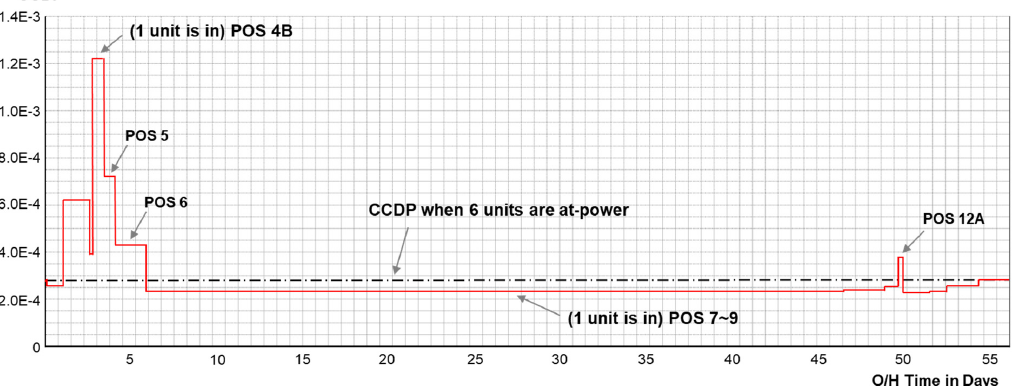
Figure 1. Example of POS-dependent site CCDP profile (one unit in shutdown, five units at pow-